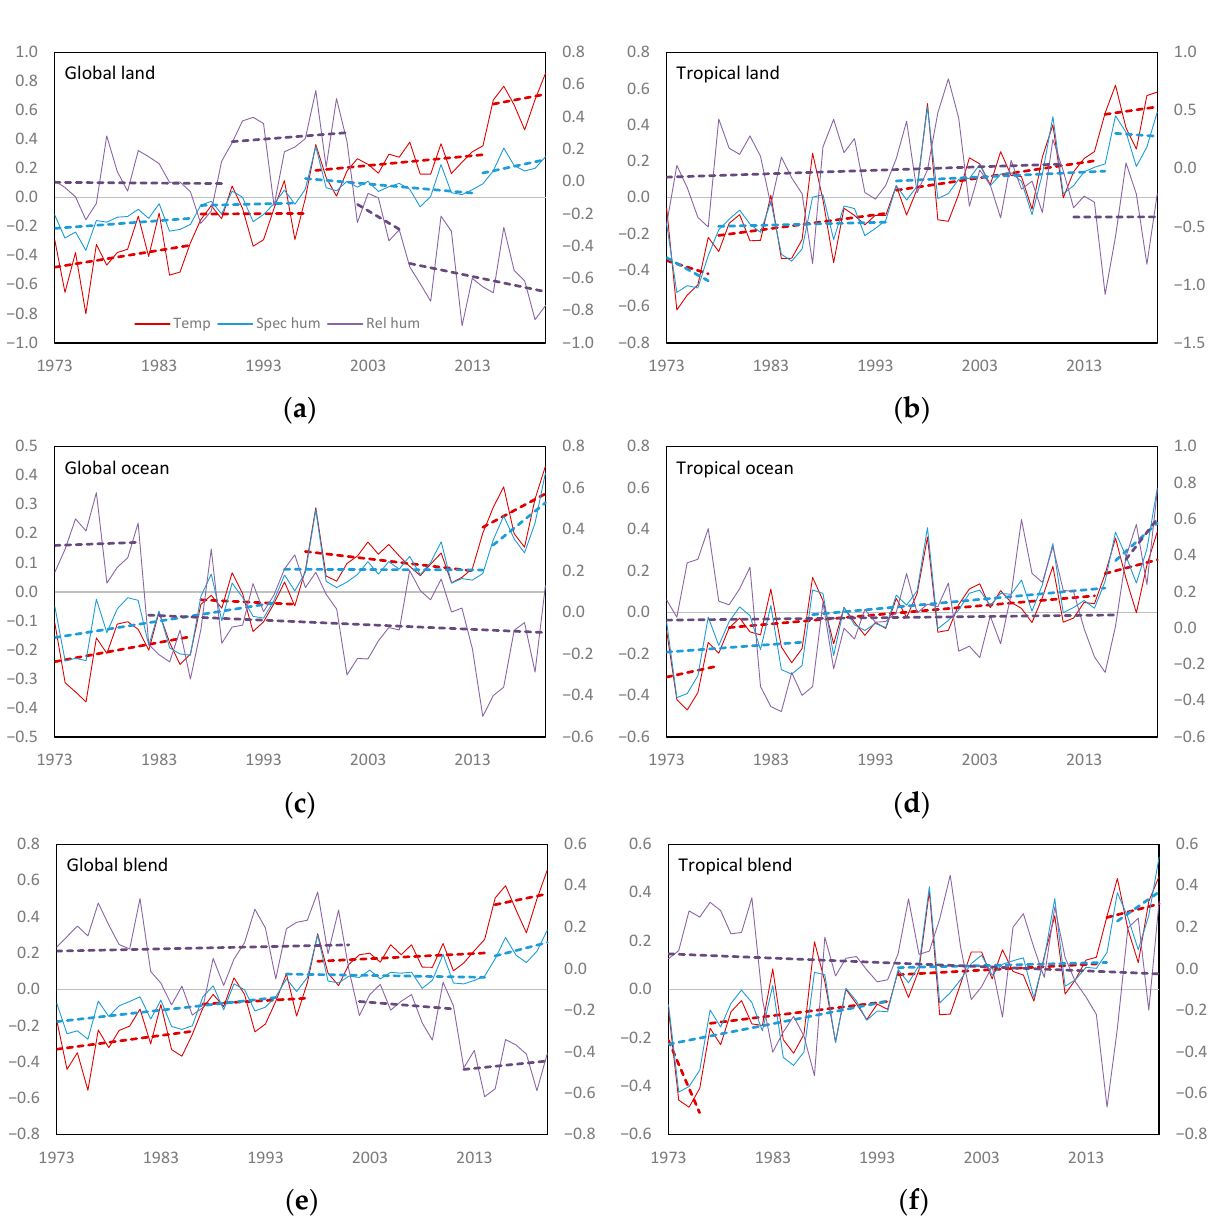
Figure 1. Annual anomalies (1981–2010) and regimes showing internal trends (dashed lines) for global and tropical average temperature (T), specific humidity (q) and relative humidity (RH) for ( a ) global land, ( b ) tropical land, ( c ) global ocean, ( d ) global ocean, ( e ) global blend and ( f ) tropical blend (Willett et al. 2020). Units are °C for temperature and g kg − 1 for specific humidity on the left axis and % for relative humidity on the right axis. Solid lines are annual values and dashed lines internal trends between shift points.